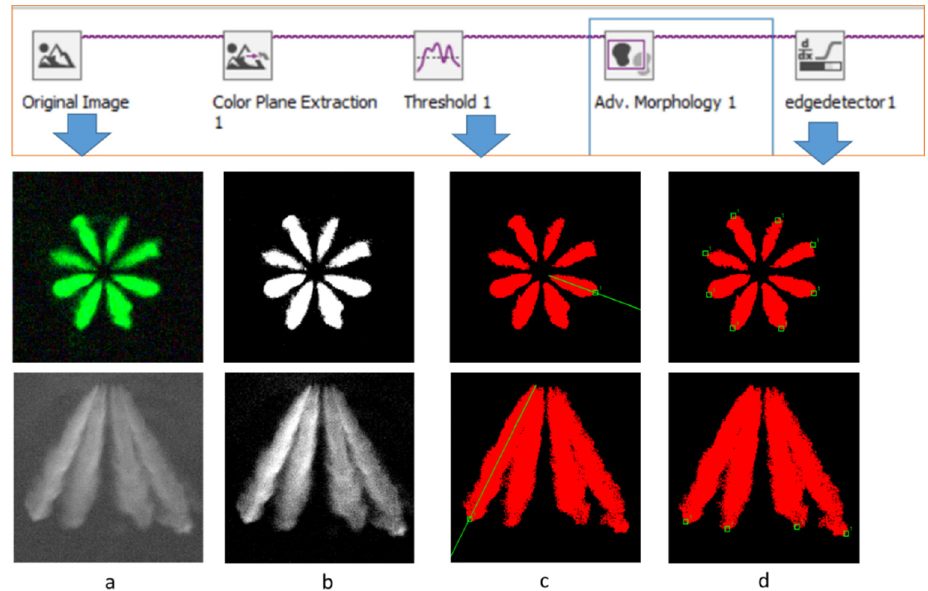
Figure 5. Steps of Vision program for evaluation of fuel spray penetration: ( a ) original image, ( b ) grayscale image, ( c ) binary image ( d ) edges along the selected spray path lines. The penetrations are estimated for all the visible jets and for each image sequence. An average value is then calculated.